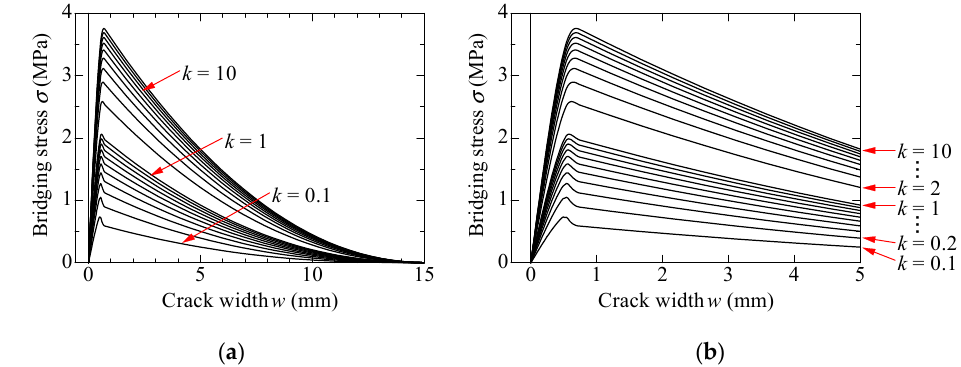
Figure 3. Calculation results of bridging law: ( a ) w = 0–15 mm; ( b ) w = 0–5 mm.